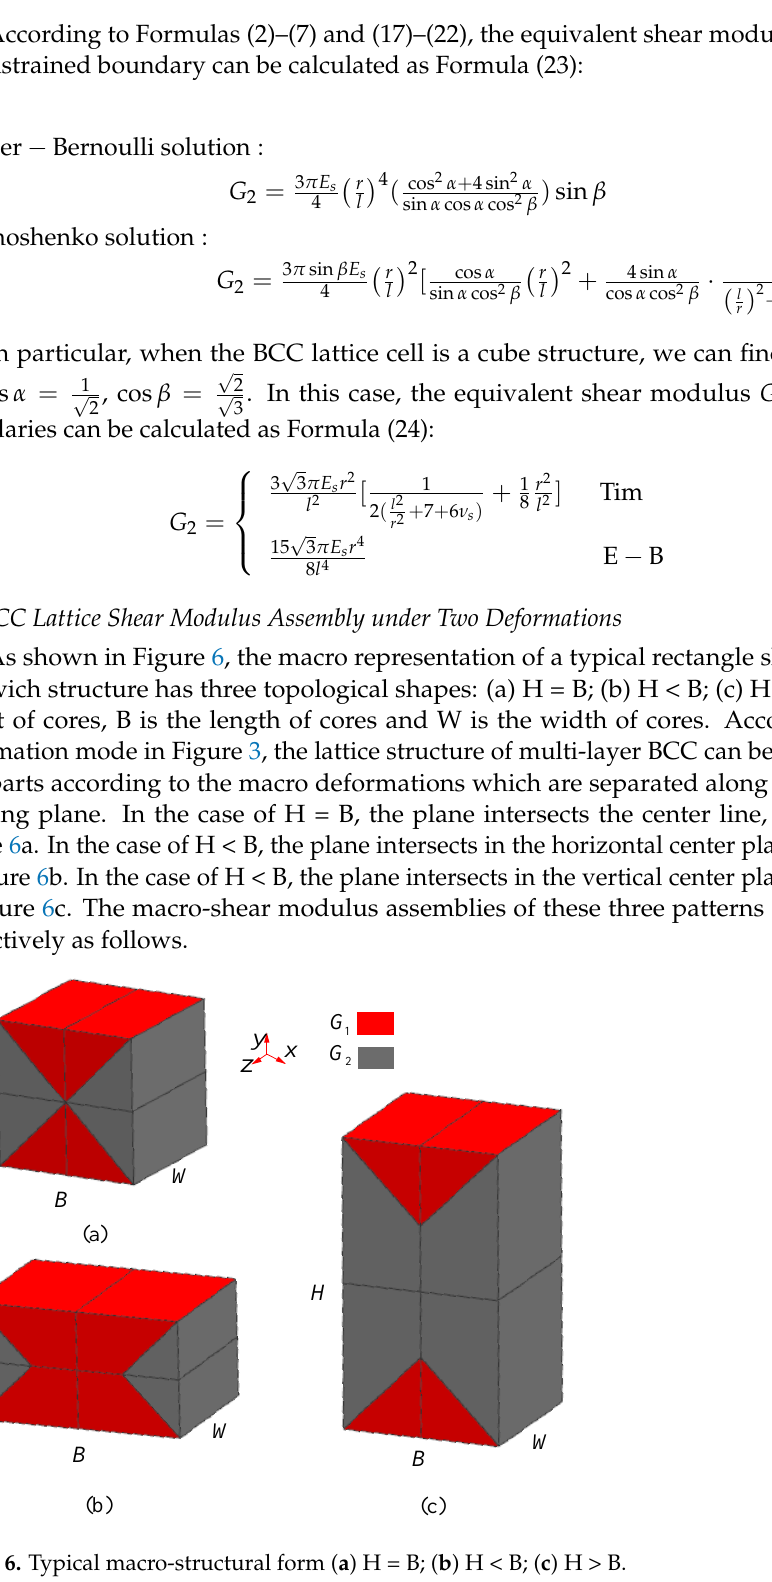
Figure 6. Typical macro-structural form ( a ) H = B; ( b ) H < B; ( c ) H > B.